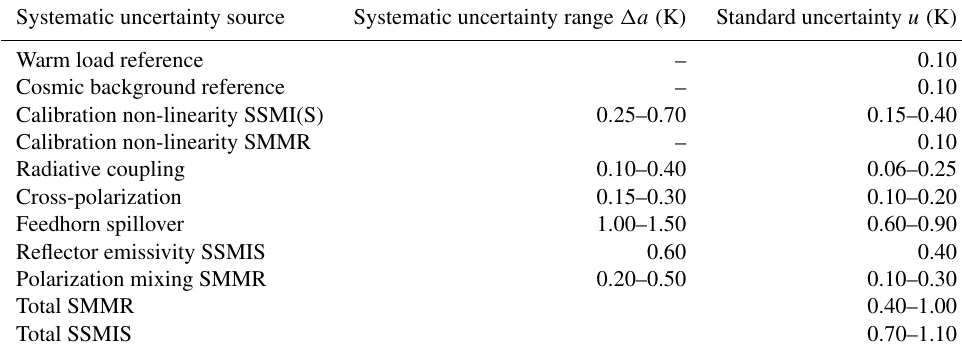
Table 1. Summary of estimated systematic uncertainty source